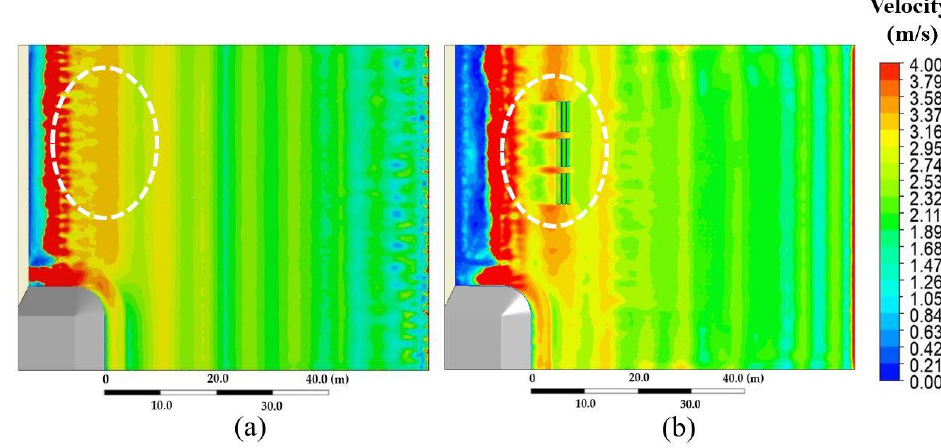
Figure 11. The water velocity of ( a ) P0 and ( b ) P1/15° .